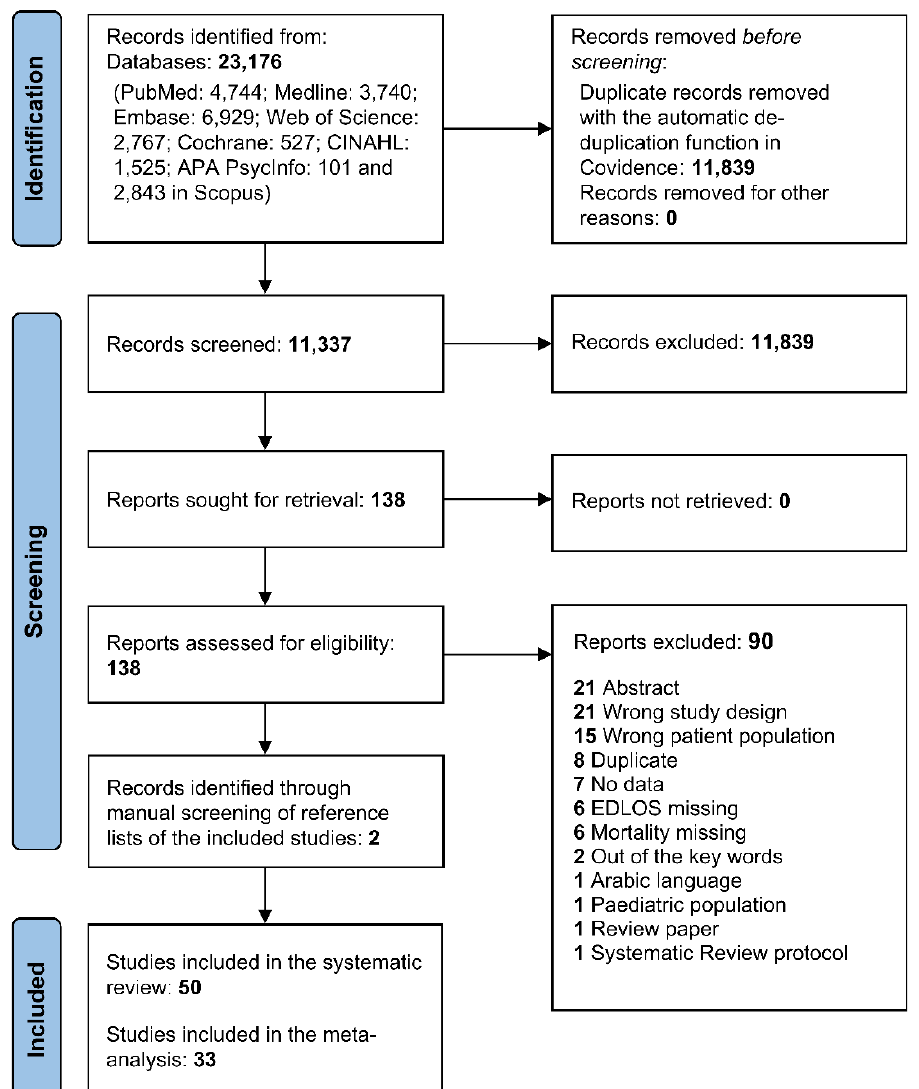
Figure 2. PRISMA 2020 flow diagram over the record de-duplication screening and selection pro- cess.